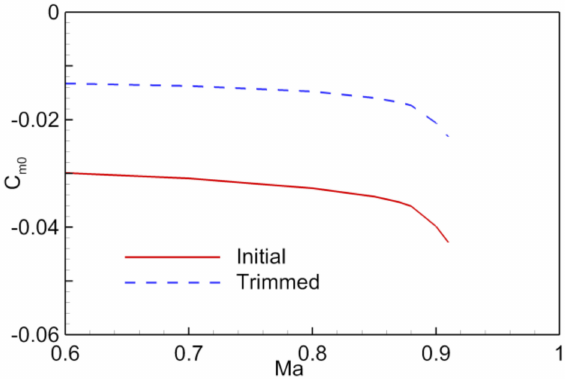
Figure 33. The zero-lift pitching moment comparison of the initial and the trimmed